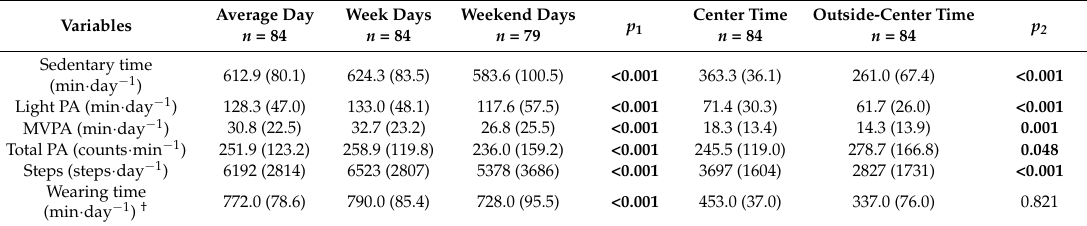
Table 2. Patterns of sedentary time and physical activity throughout the week in adults and older adults with